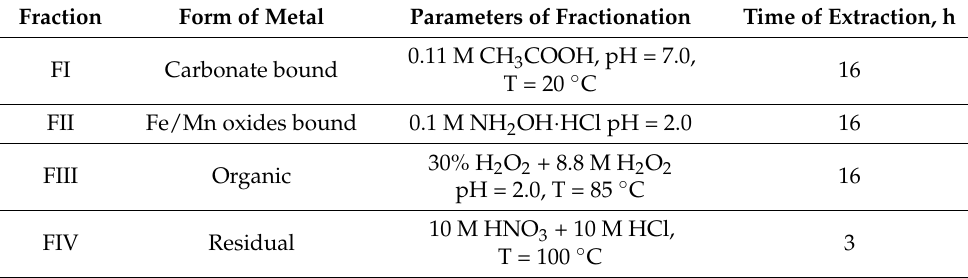
Table 3. Method of metal speciation heavy metals in sewage sludge [43,44].